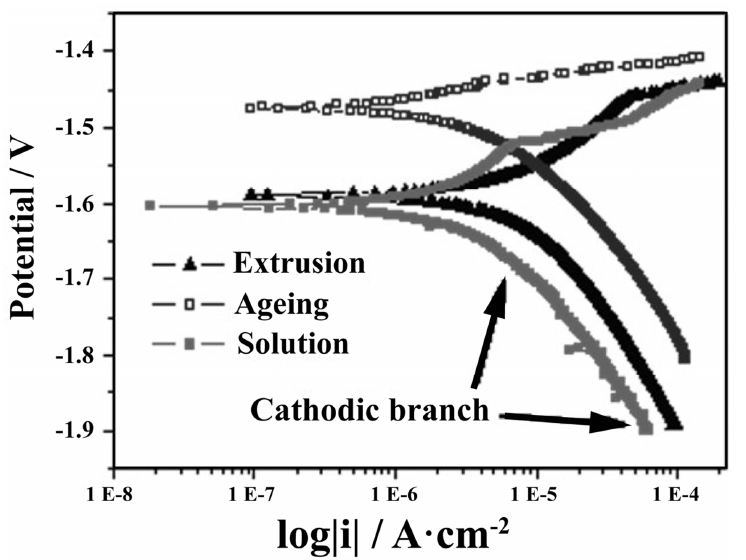
Figure 7. Polarization curves for Mg–6Zn in various states. The T4 treated samples exhibited the lowest corrosion current density, followed by T6 and the extruded samples [169].